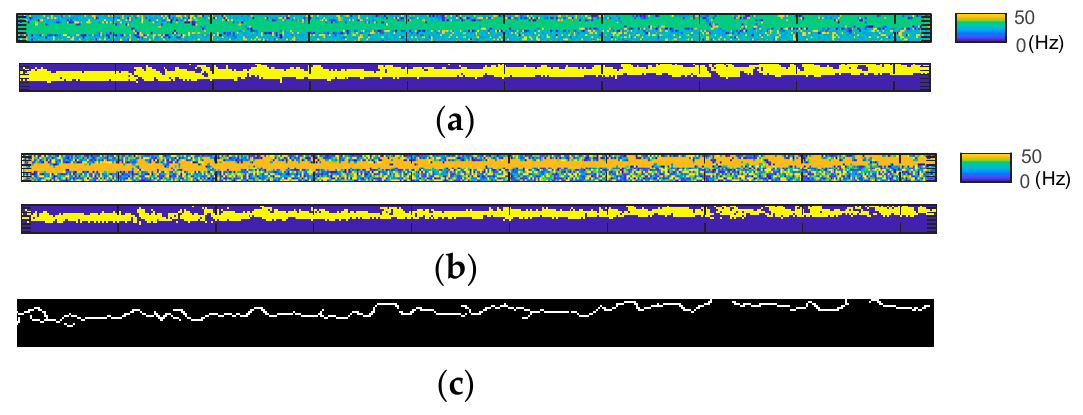
Figure 8. Two representative results and Canny edge detection algorithm result: ( a ) 30 Hz excitation result: prediction result map and pixels predicted around 30 Hz (maximum value of histogram) highlighted; ( b ) 40 Hz excitation result: prediction result map and pixels predicted around 40 Hz (maximum value of histogram) highlighted; ( c ) Pixels used in edge enhancement.